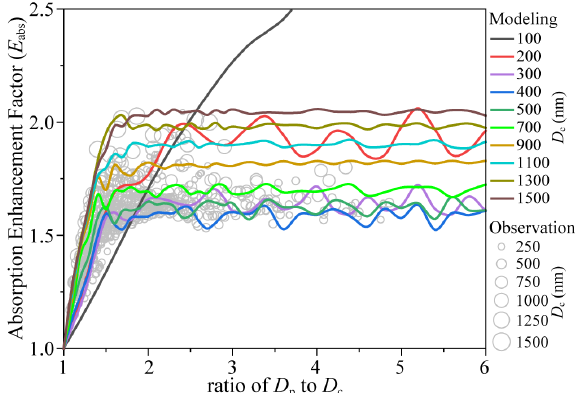
Figure 10. Mie-theory-calculated light absorption enhancement factors ( E abs ) of modeled core–shell POA–SIA particles (i.e., ra- tio of ACS POA–SIA to ACS POAcore ) with different POA core di- ameters ( D c ) as a function of the particle-to-core diameter ratio ( D p /D c ) at a wavelength of 550nm (solid lines). A refractive in- dex of 1.55 − 0 i for non-light-absorbing SIA coating (Denjean et al., 2014) and 1.67 − 0.27 i for light-absorbing POA cores (Alexan- der et al., 2008) were adopted at a wavelength of 550nm. The open circles represent all the observed POA–SIA particles during all the polluted periods at the Gucheng rural and Beijing urban